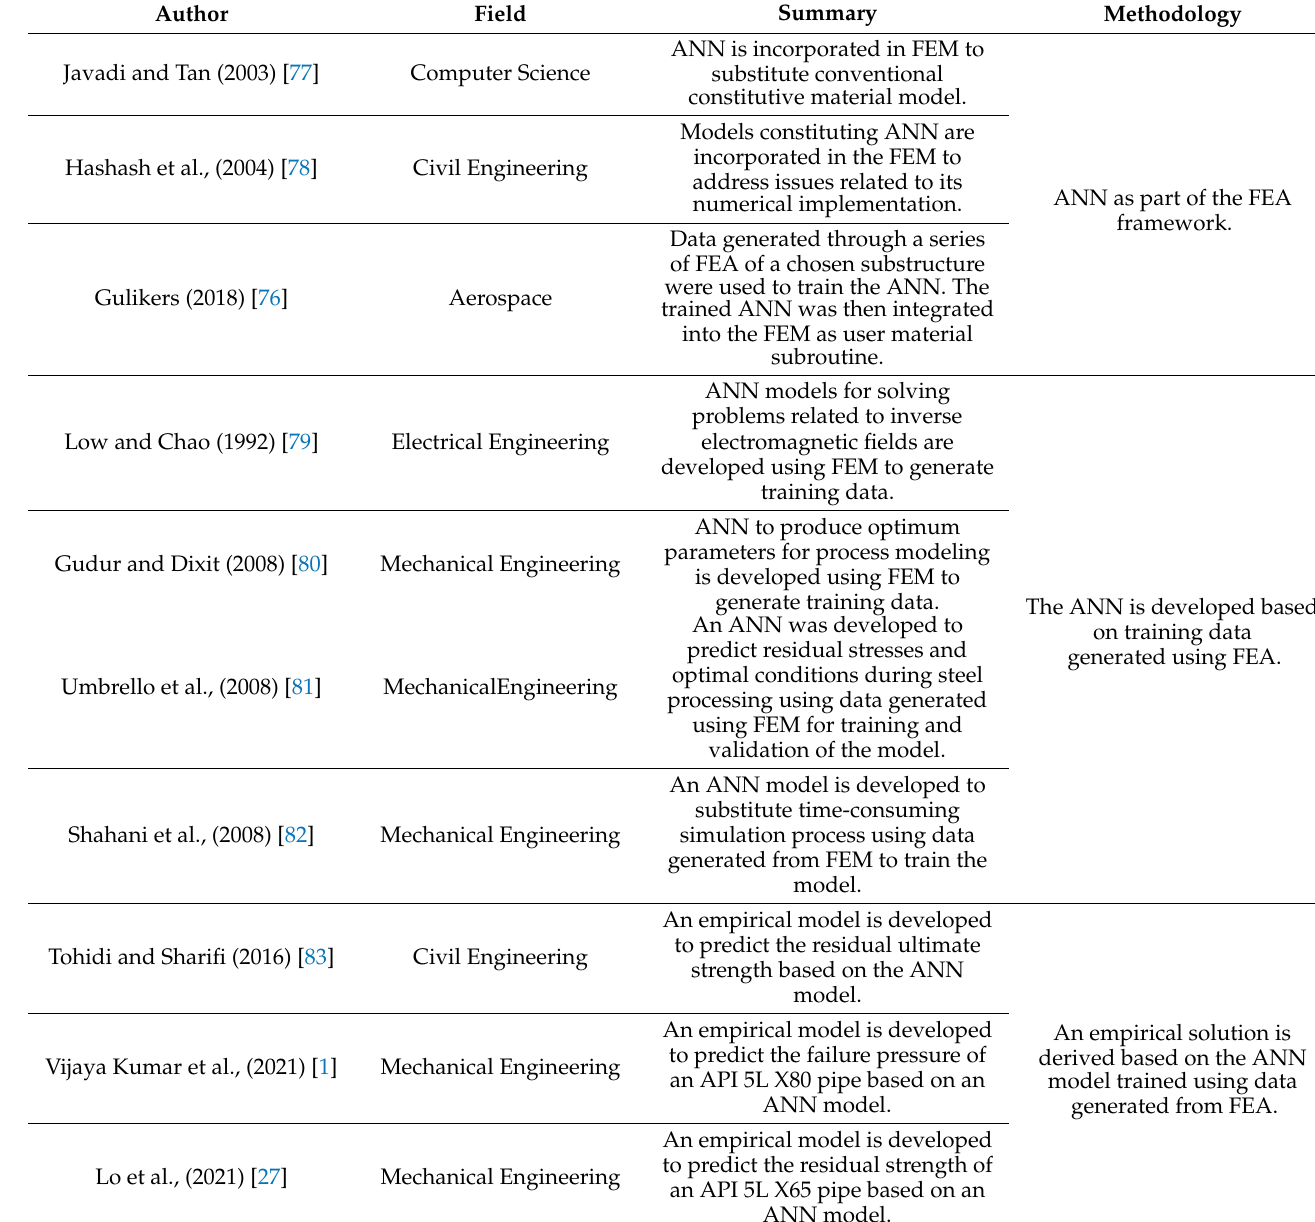
Table 7. Types of approaches for the integration of FEA and